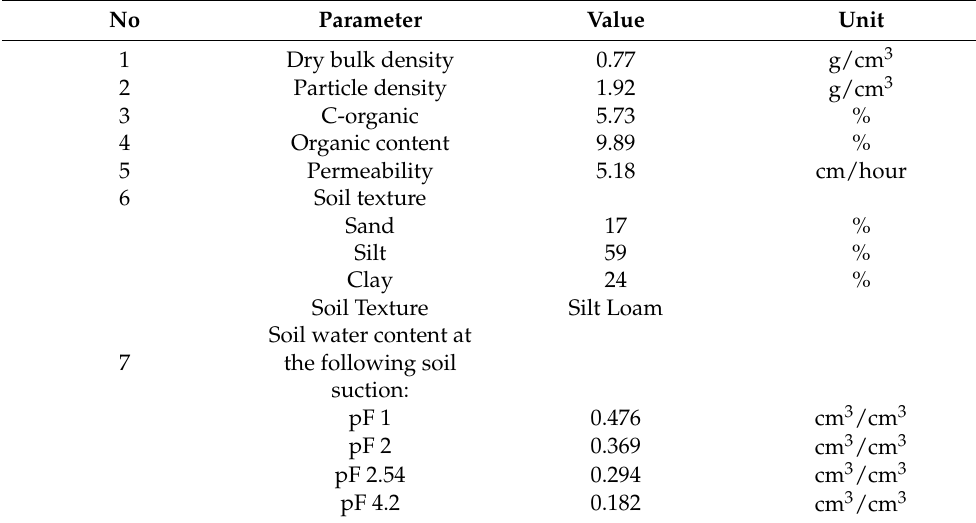
Table 1. The physical characteristics of planting media soil.